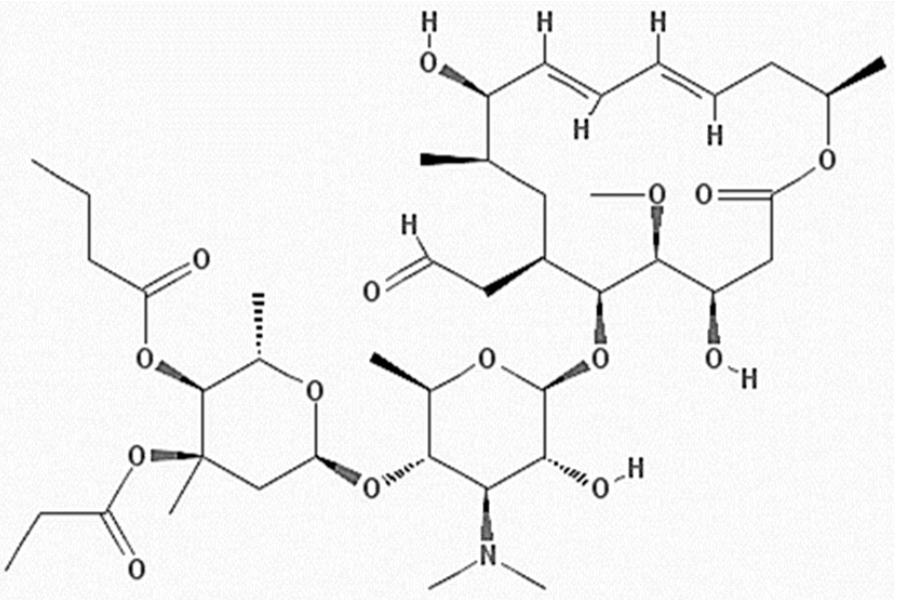
Figure 1. Chemical structure of Rokitamycin (C 42 H 69 NO 15